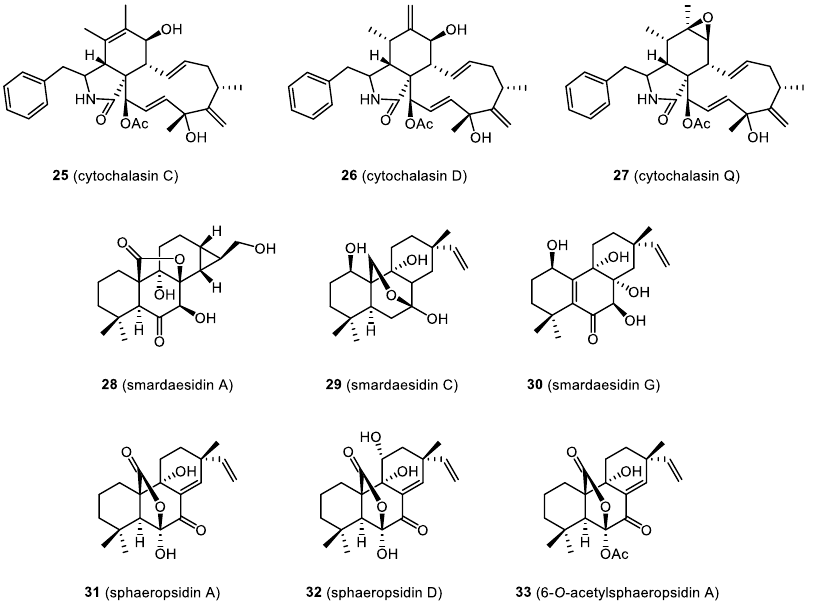
Figure 6. N-containing compounds ( 25 – 27 ) and pimarane diterpenoids ( 28 – 33 ) with cytotoxic and anticancer activities.